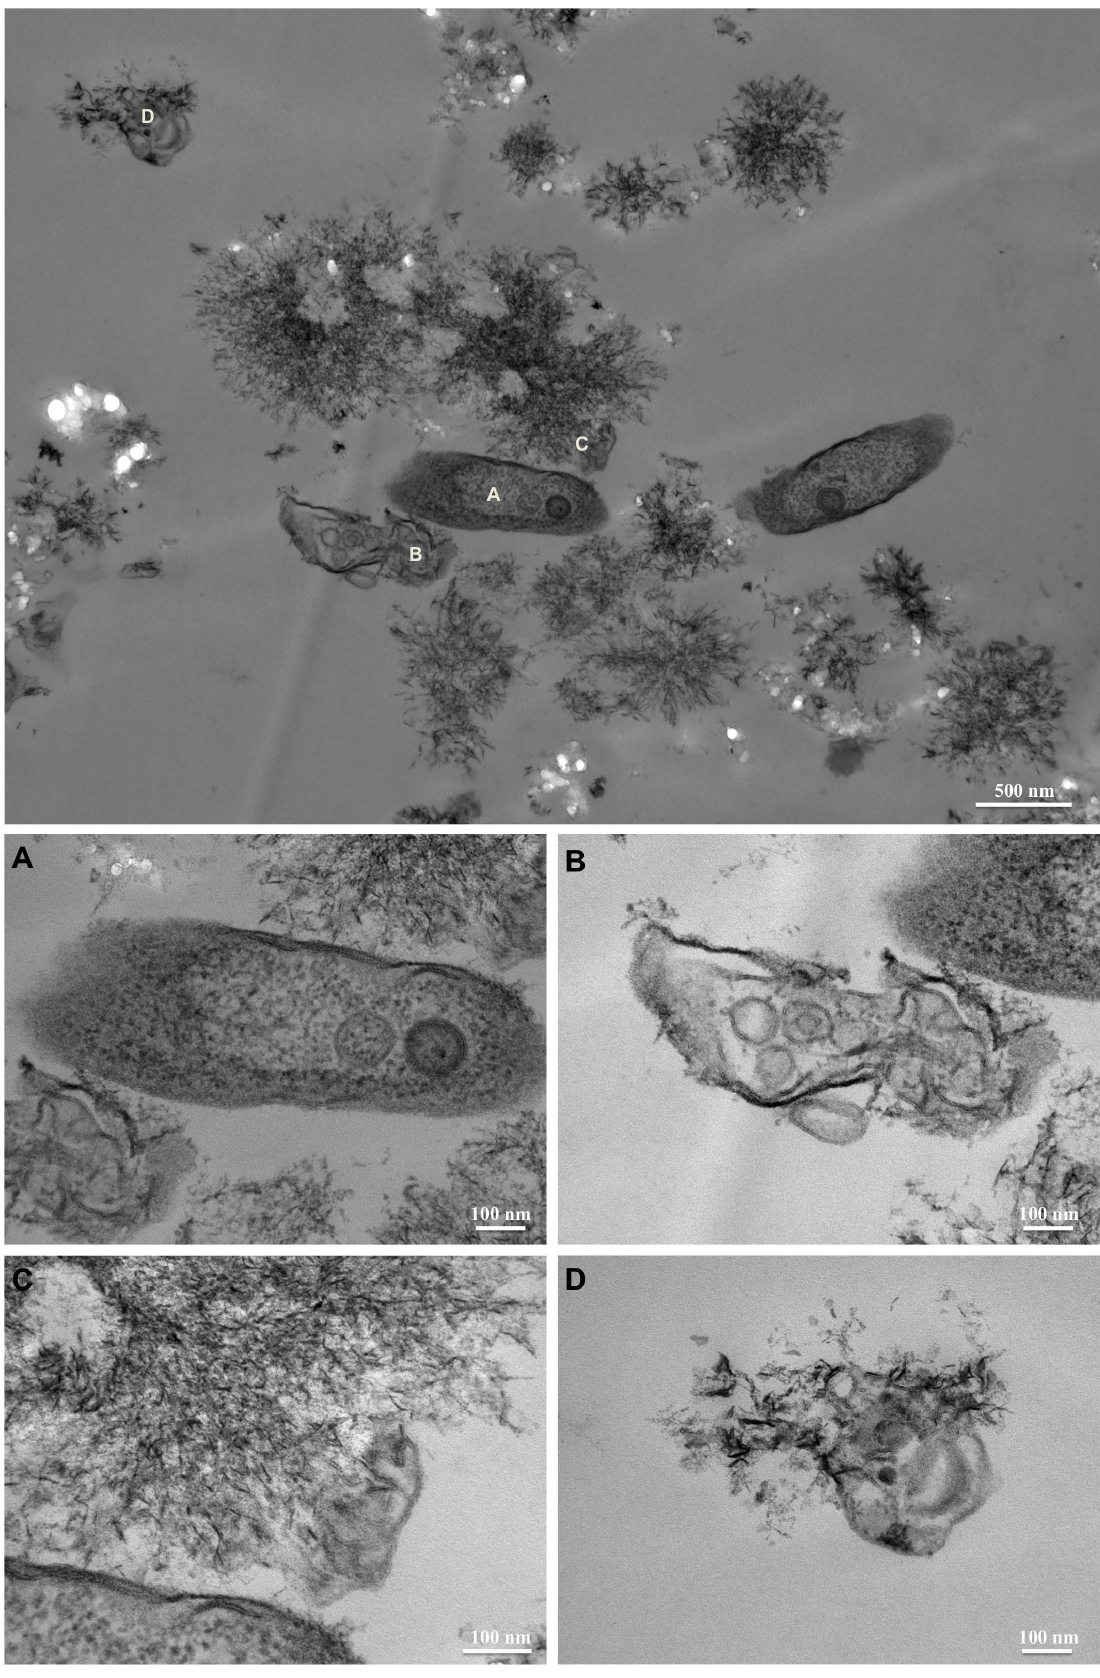
Figure 10. TEM imaging of the inoculated DSMZ medium sampled after 6 days of culture. A to D show magnification of cell lysis and spatial association of the lysed vesicle of C. hydrogenoformans and the interpreted HAP. doi:10.1371/journal.pone.0089480.g010 PLOS ONE |